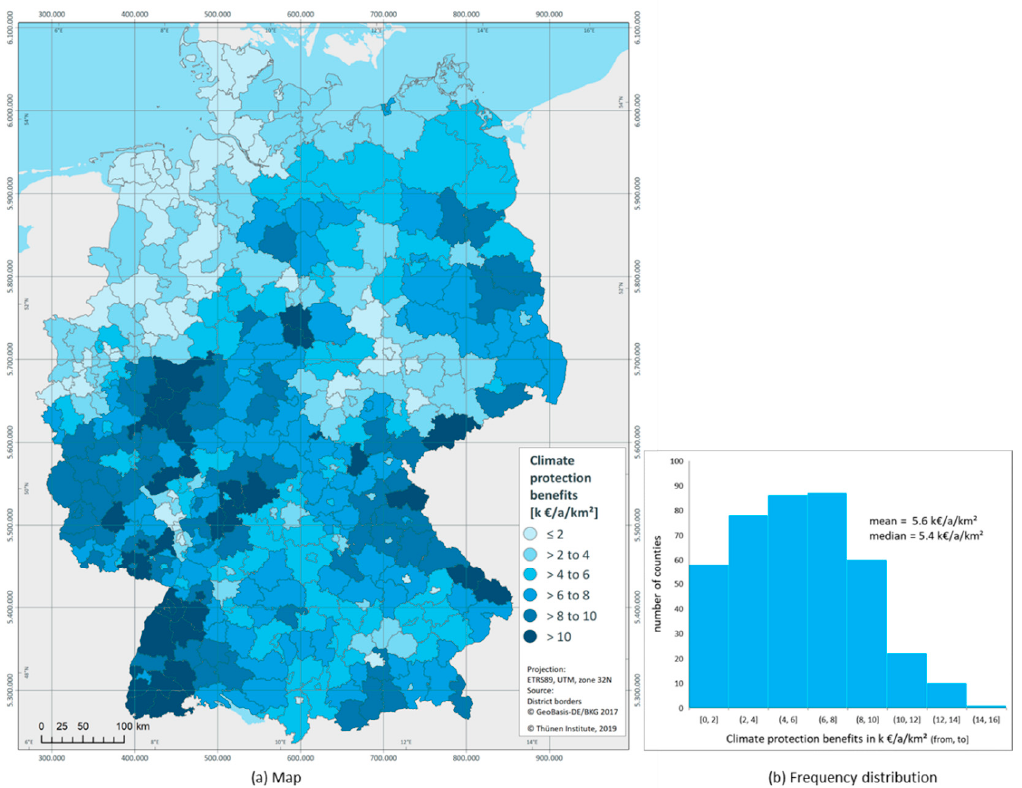
Figure 6. Annual climate protection benefits due to carbon sequestration in the counties. The spatial distribution pattern is very similar to that of the raw wood potential. This is not surprising, because wherever forests are abundant, there are also high potentials for raw wood production as well as for climate protection services—both are causally related to wood increment. Therefore, the same regional foci emerge for both climate protection and wood production. Differences in the patterns occur because, on the climate protection side, the different carbon densities of the tree species as well as the utilization of their timber play a role; in contrast, there are no price differences between the individual tree species at this point. The frequency distribution is also quite similar to that of the raw wood potentials. In more than a third of the counties, climate protection benefits amount to less than 4 k€/a/km 2 , but the value range extends to 14.5 k€/a/km 2 . The valuation is based on a reference scenario with a harvesting intensity like today, in which increments exceed harvests. For direct comparability with the volume basis of the timber revenue potential, an alternative scenario is defined in which all sustainably harvestable increments are harvested, i.e., where harvests equal increments. In this sce- nario, climate protection benefits would be lower by almost €0.2 billion/a, totaling €1.9 billion/a. In other words, a scenario of increasing harvests to the full increment would cost society about €0.2 billion/a in terms of foregone climate protection benefits. 3.3. Annual Benefits of Forest Recreation by Local Residents Summed across all municipalities, the aggregate benefits of everyday forest recrea- tion (i.e., excluding holiday trips) amount to €2.4 billion/a. This result is obtained after extrapolation to the total population without any deductions (82.8 million inhabitants, in- cluding minors). Extrapolated only to the population over 14 years of age (72.6 million people), the result would be 2.1 billion €/a; extrapolated to the adult population (69.3 mil- lion people), it would amount to 2.0 billion €/a.